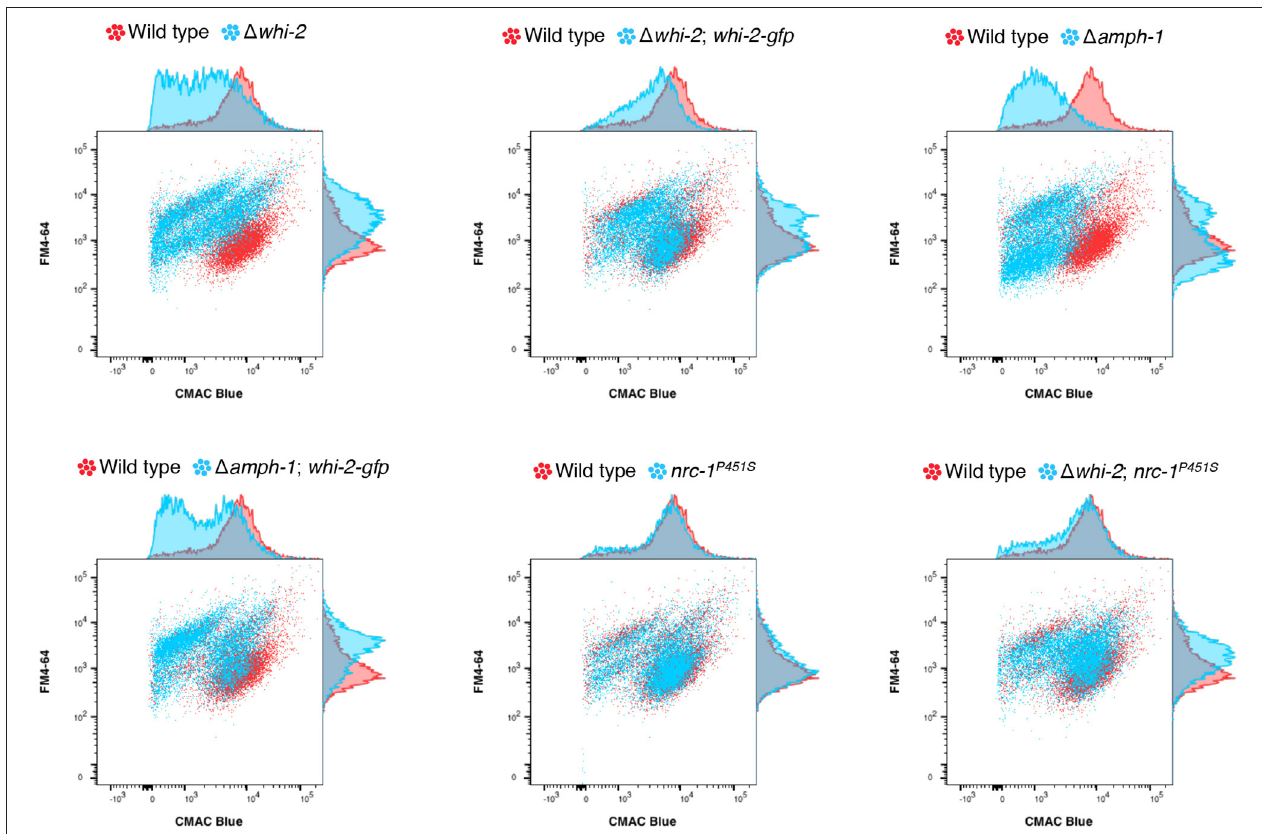
FIGURE 5 | The mis-expression of nrc-1 P 451 S and whi-2-gfp compensates for the endocytosis defect of 1 whi-2 and 1 amph-1 cells, respectively. The wild type (red) and other indicated strains (blue) were stained with FM4-64 and CMAC Blue to label endocytic intermediates and vacuolar lumens, respectively. Note that while the wild type shows an overlap of FM4-64 and CMAC Blue, indicating that plasma membrane-derived endocytic intermediates are guided to the vacuoles, cells lacking whi-2 and amph-1 displayed a shift in red/blue fluorescence. n = 4. Shown is a representative set of experiments.